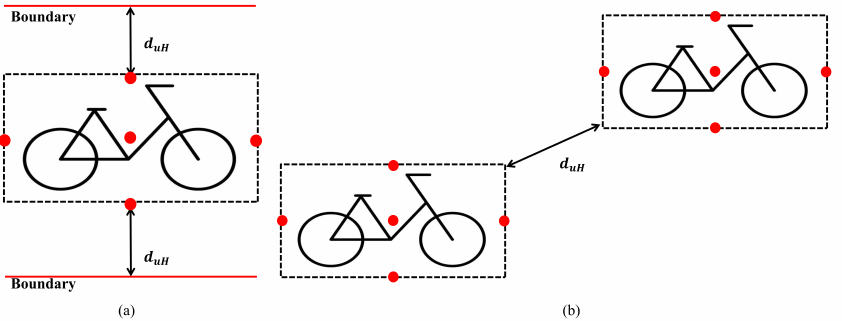
Figure 2. The concept of d uH . ( a ) The distance between non-motorized vehicles and the boundary. ( b ) The distance between non-motorized vehicles and non-motorized